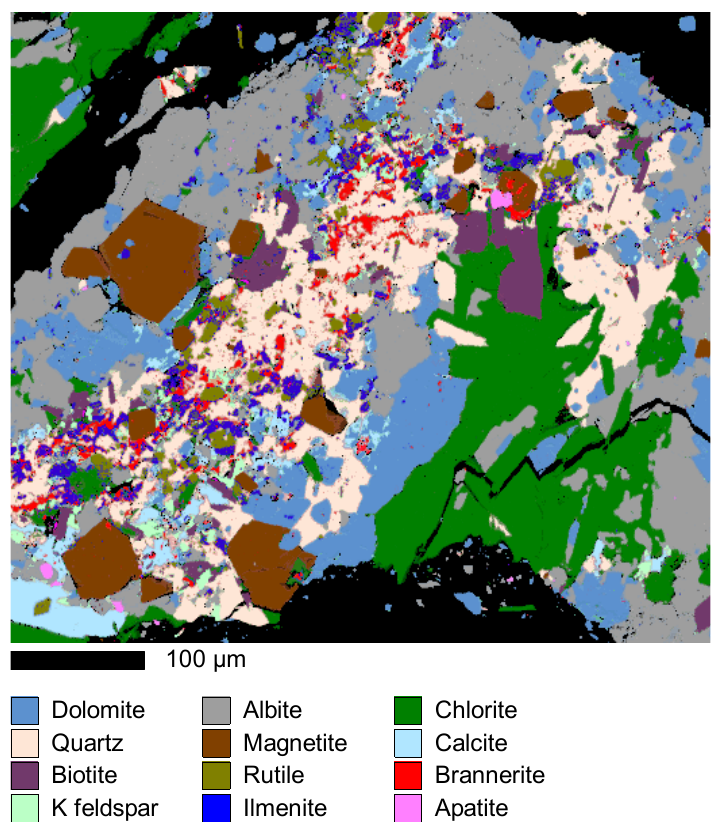
Figure 11. Phase patched map of sample SRD0078B from Skal.